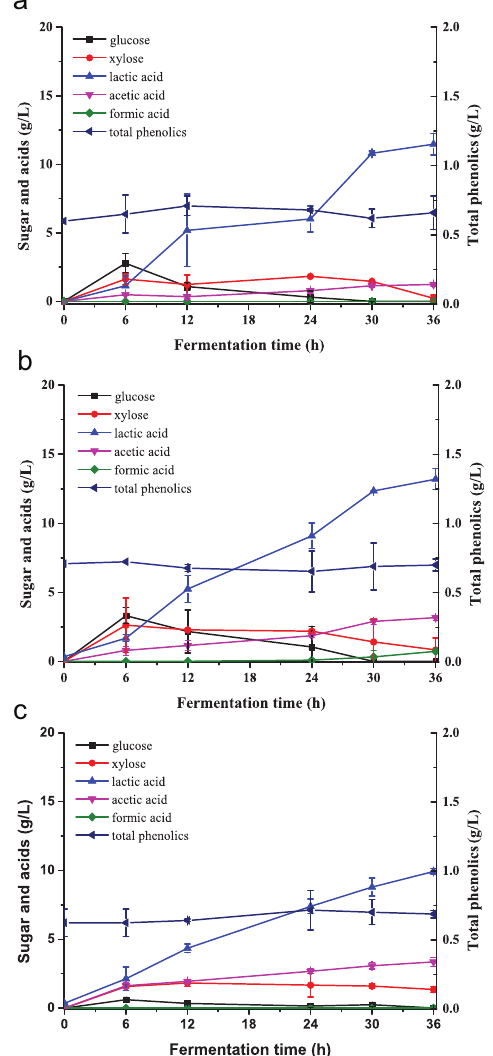
Figure 6. Co-culture of K. huakuii LAM0618 T and B. coagulans LA204 for lactic acid fermentation from 5% ( w / w ) NH 3 /H 2 O 2 -pretreated but unwashed corn stover in a 500 mL flask. Fermentation curves for glucose, xylose, lactic acid, acetic acid, formic acid, and total phenolic inhibitors were shown. ( a ) inoculating 10% K. huakuii LAM0618 T and 10% B. coagulans LA204 at 150 rpm, 30 ◦ C or ( b ) at 50 ◦ C, and ( c ) inoculating 10% B. coagulans LA204 at 150 rpm, 50 ◦ C as the control group. All experiments were performed in duplicate and results are presented as mean ± SD. Error bars indicate